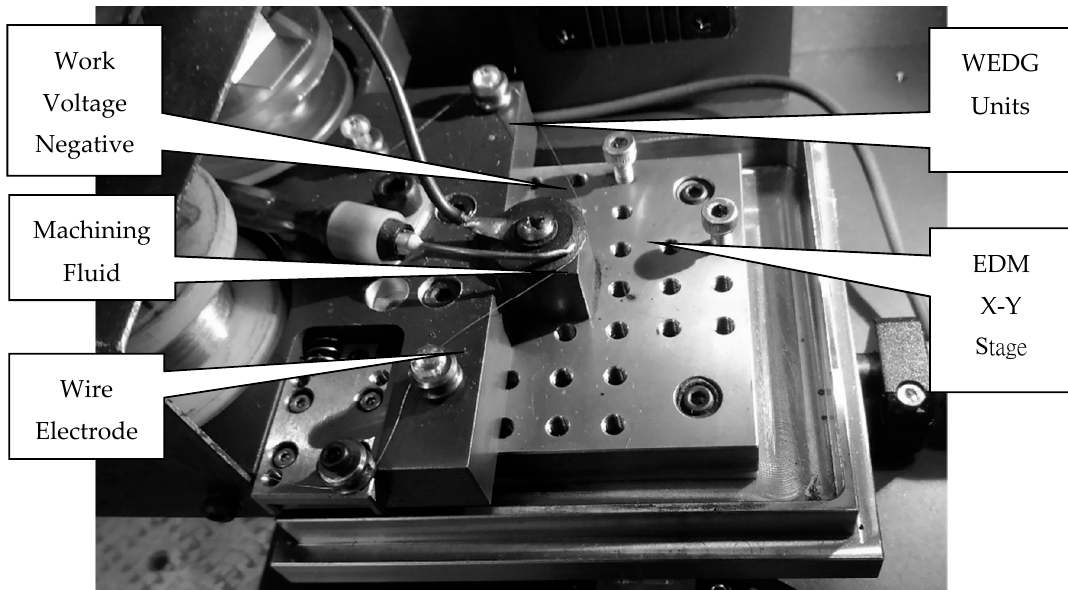
Figure 6. Wire-electro-discharge grinding (WEDG) technology unit attached to the desktop micro-EDM system.